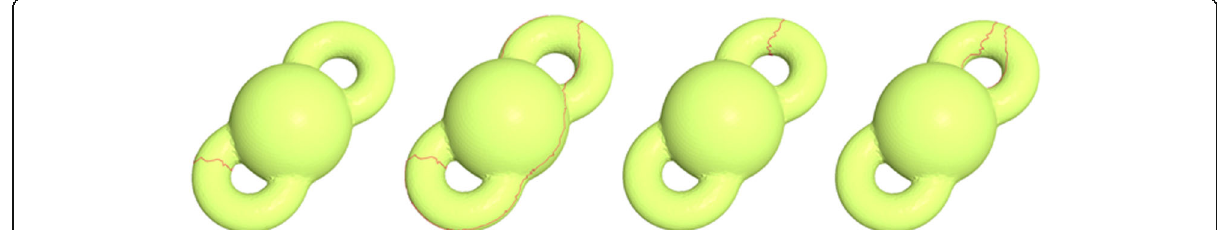
Fig. 2 Homology group basis for a graph embedded on a genus two